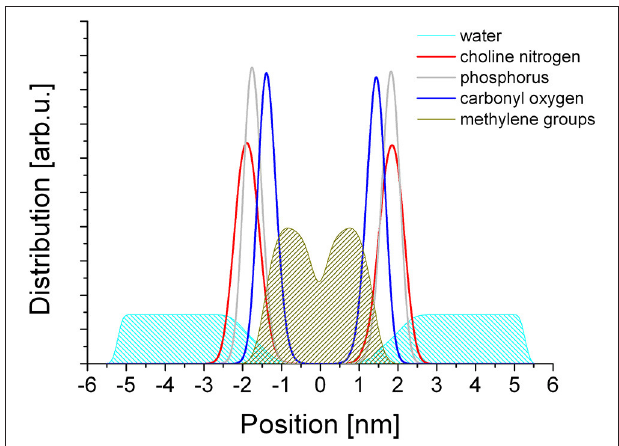
FIGURE 2 | Distribution of the lipid moieties in a cross section of the equilibrated